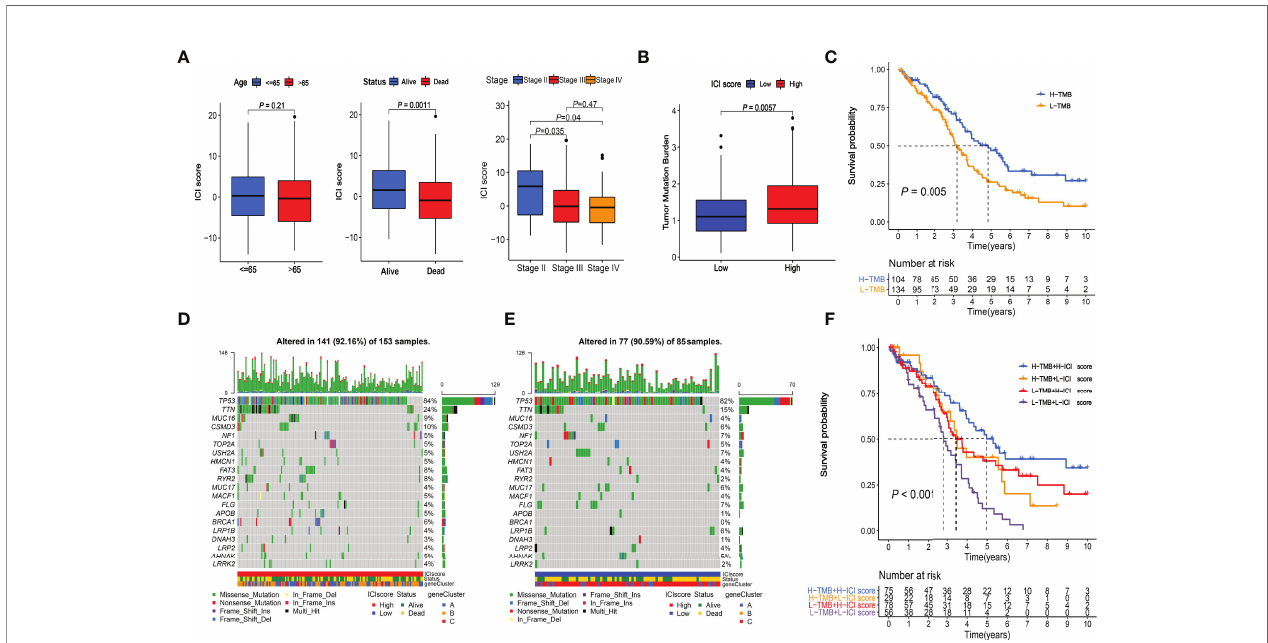
FIGURE 6 | Clinical relevance of ICI score and combined survival analysis with TMB. (A) Relationships between ICI scores and Age, Survival Status, and Stages. (B) Comparison of TMB values between High and Low ICI score groups. Wilcoxon test P = 0.0057. (C) Kaplan-Meier curve of High-TMB and Low-TMB groups. Log-rank test P = 0.005. (D) Somatic alterations landscapes of top 20 genes in high ICI score group. (E) Somatic alterations landscapes of top 20 genes in low ICI score group. (F) Combined survival analysis with TMB. Log-rank test P <